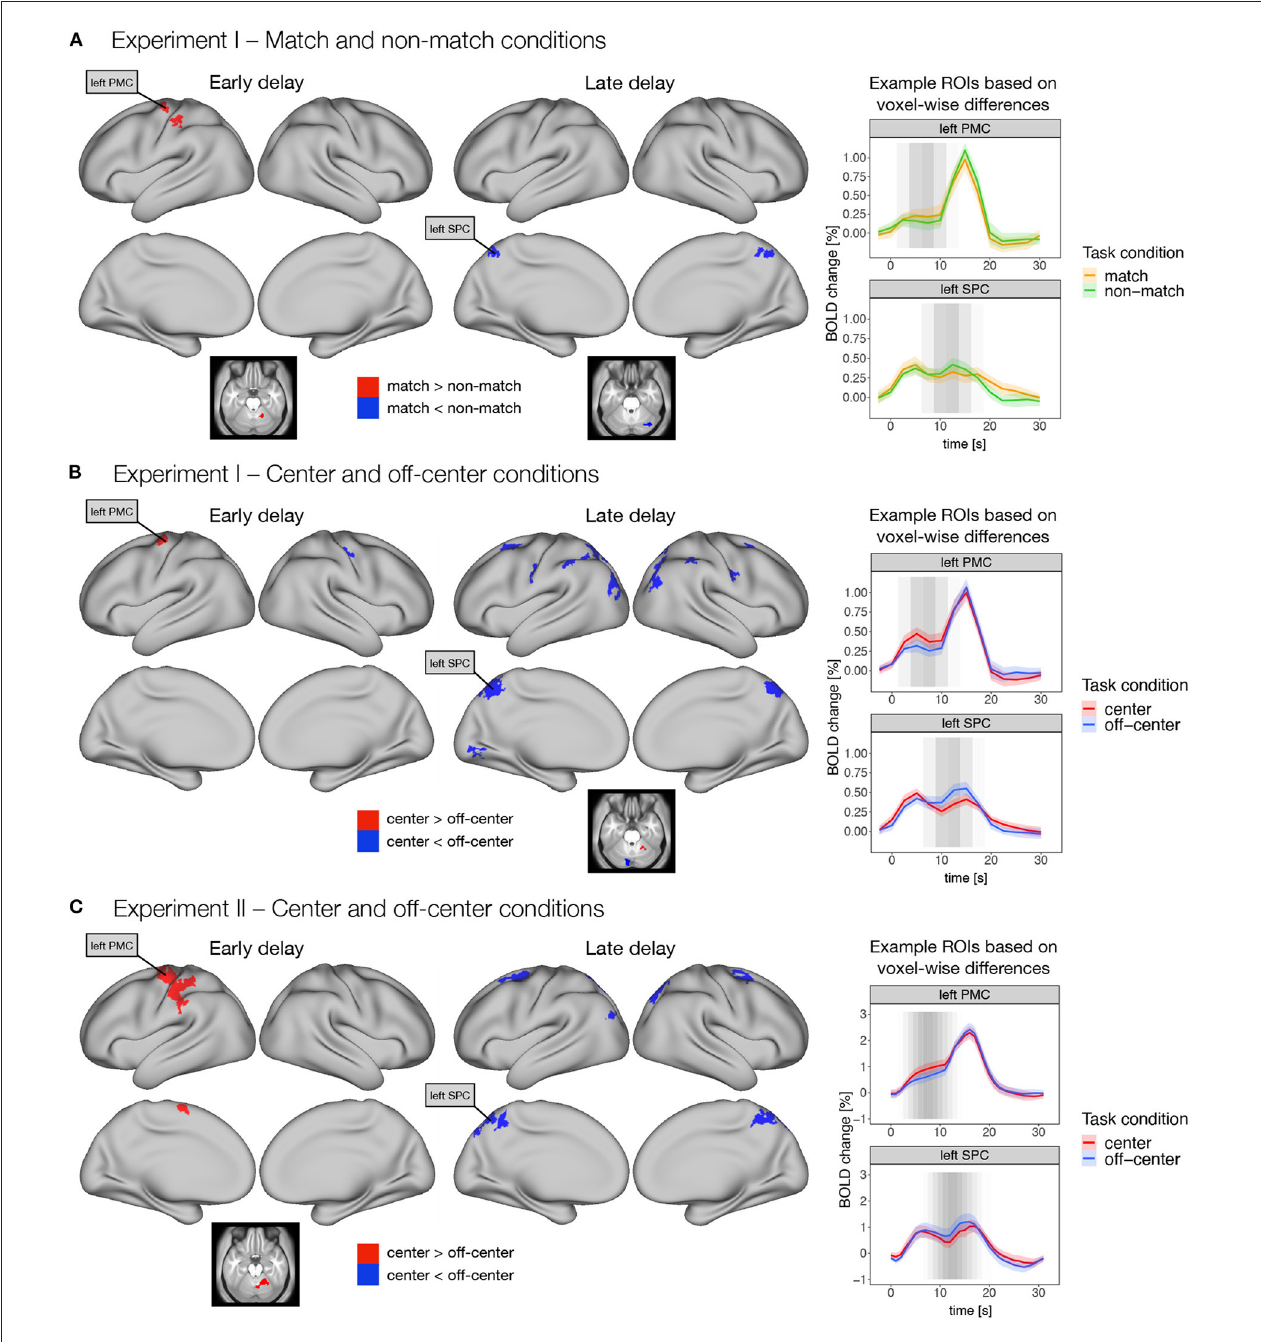
FIGURE 4 | Differences in early and late phases of the delay activity between task conditions thought to promote either retrospective sensory or prospective motor coding, respectively. Specifically, dense whole-brain results are presented for contrasts between (A) match and non-match conditions, and (B) center and off-center conditions in Experiment I, and (C) center and off-center conditions in Experiment II. Early delay was defined as activity in the first half of the delay period, and late delay was defined as activity in the second half of the delay period. Differences between task conditions were calculated using permutation t -tests on dense whole-brain data, corrected with cluster ( C = 3.1) FWE, and thresholded at p < 0.05. Based on the thresholded images, we identified two example ROIs (i.e., left premotor cortex—PMC and left superior parietal cortex—SPC) that exhibited significant differences across different task conditions and experiments. We then extracted the average activity within each ROI throughout the entire trial for each task condition. The zero point represents the onset of target presentation. The gray shading in the plots marks the expected contribution of the early and late delay periods to the reconstructed trial response based on the hemodynamic response